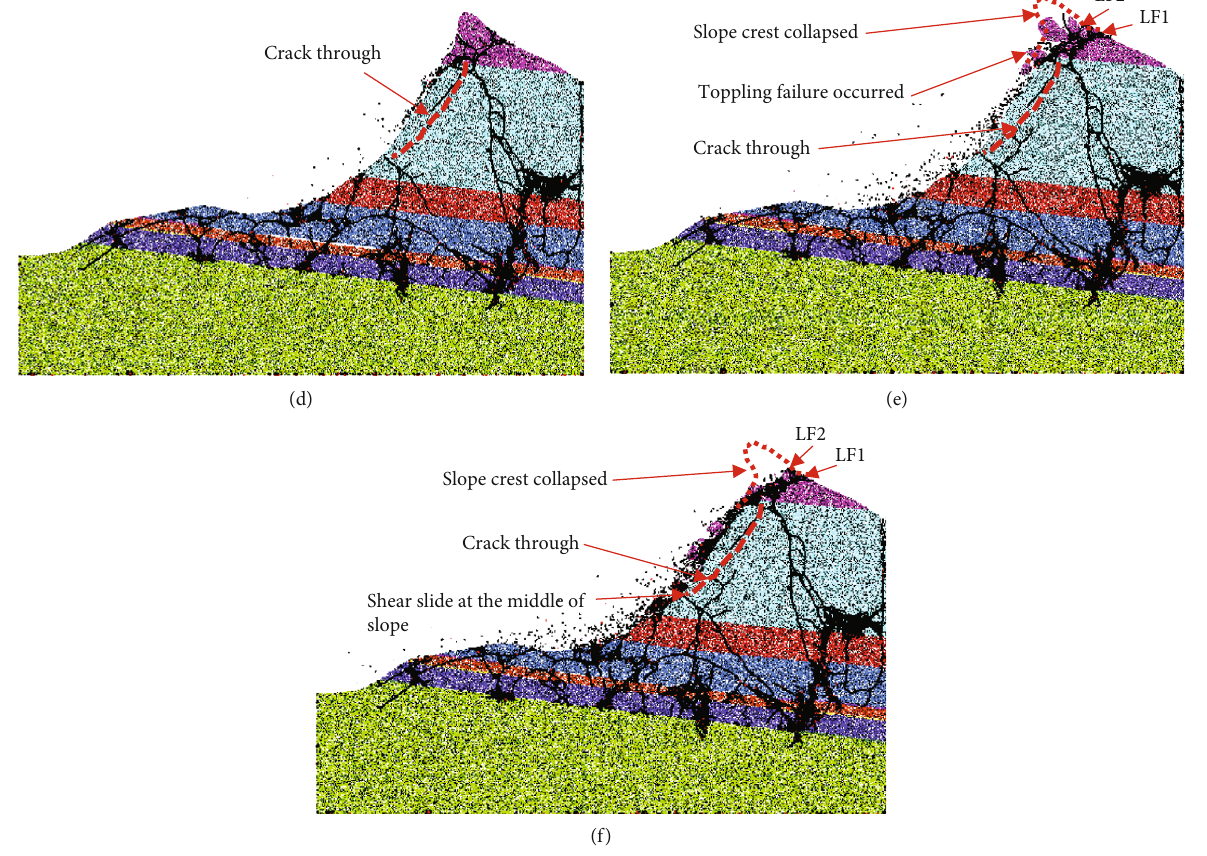
Figure 14: Failure process of the Pusa